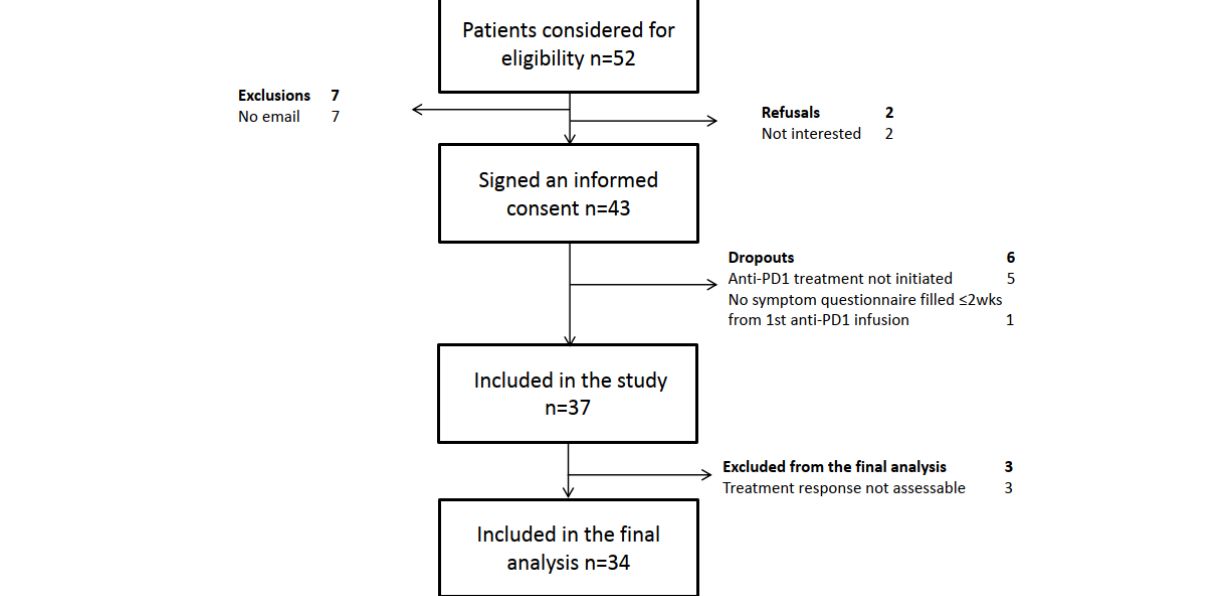
Figure 1. Flowchart of patient accrual and analysis.